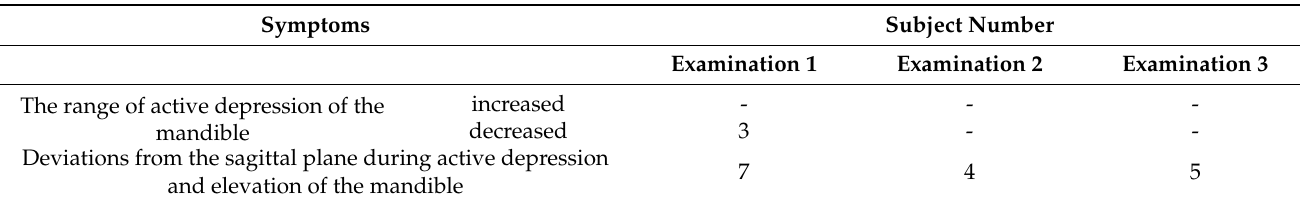
Table 3. Results of the physiotherapeutic examination of the masticatory organ obtained in group